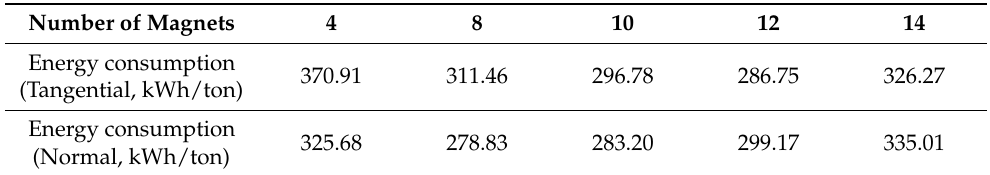
Figure 11. Analysis result according to the number of permanent magnets: ( a ) result of normal model; ( b ) result of tangential model. Table 3. Energy consumption according to the number of magnets.